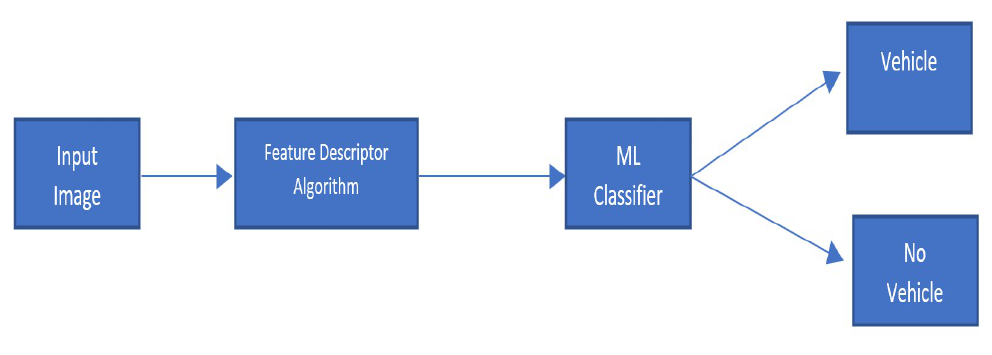
Figure 1. General processing pipeline of object detection with machine learning